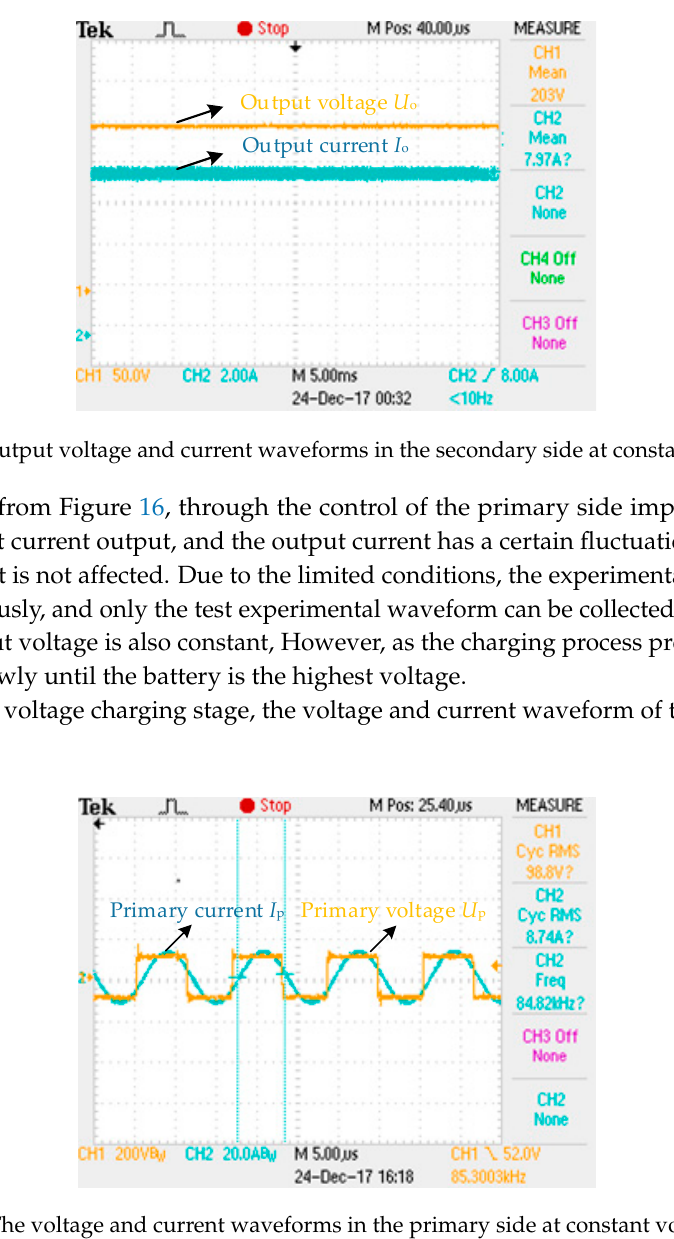
Figure 17. The voltage and current waveforms in the primary side at constant voltage stage.